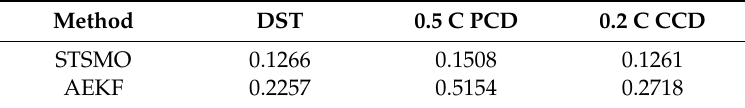
Table 3. Computation time for SOC estimation of two methods (unit: